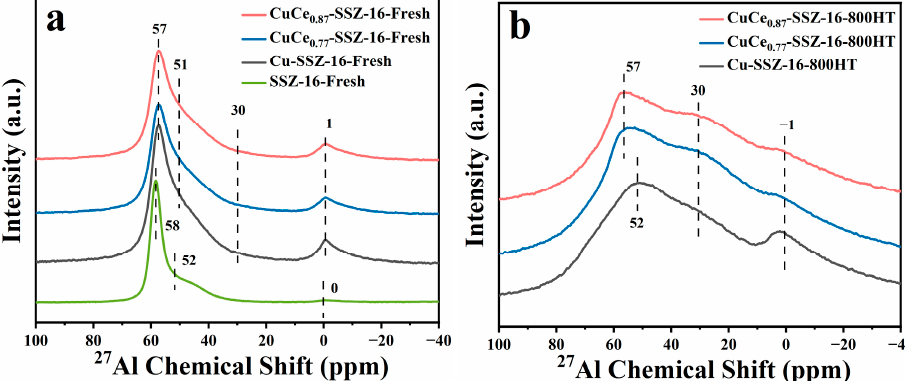
Figure 6. 27 Al MAS NMR spectra of ( a ) SSZ-16-Fresh, Cu-SSZ-16-Fresh, CuCe 0.77 -SSZ-16-Fresh and CuCe 0.87 -SSZ-16-Fresh, and ( b ) Cu-SSZ-16-800HT, CuCe 0.77 -SSZ-16-800HT, and CuCe 0.87 -SSZ-16-800HT. Table 2. Quantitative analysis of the 27 Al NMR results of SSZ-16-Fresh, Cu-SSZ-16-Fresh, CuCe 0.77 - SSZ-16-Fresh, and CuCe 0.87 -SSZ-16-Fresh.